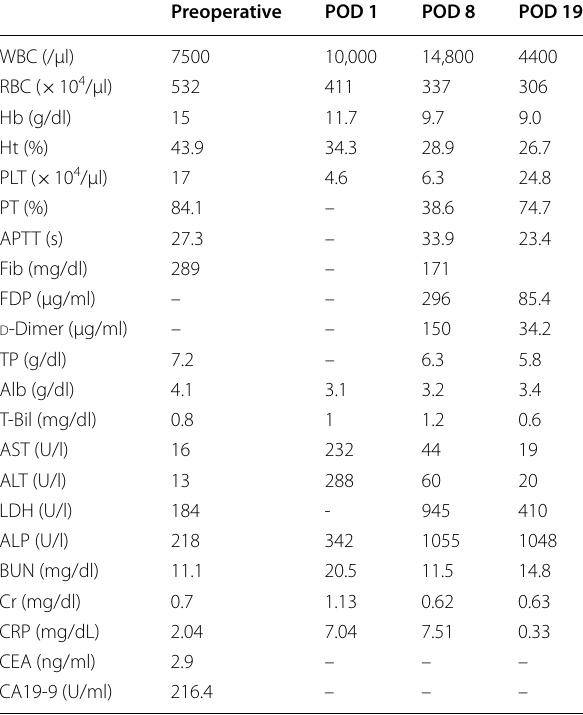
POD postoperative